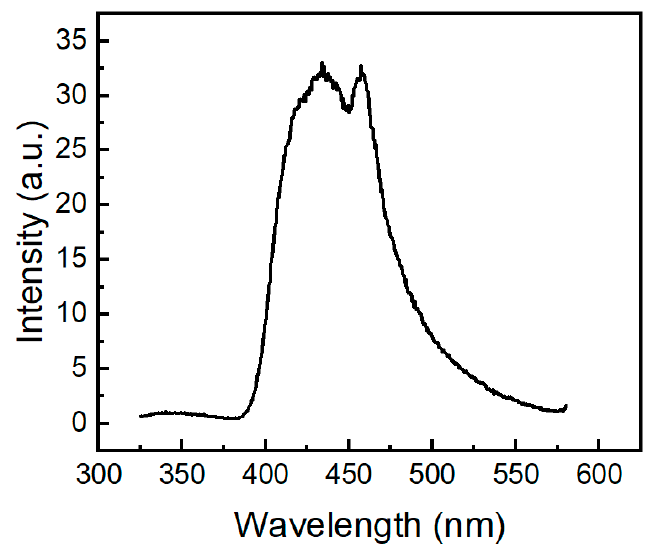
Figure 10. Phosphorescence spectrum of molecule 2a (200 µ M) in 2-methyltetrahydrofuran glass at 77 K excited at 291 nm.